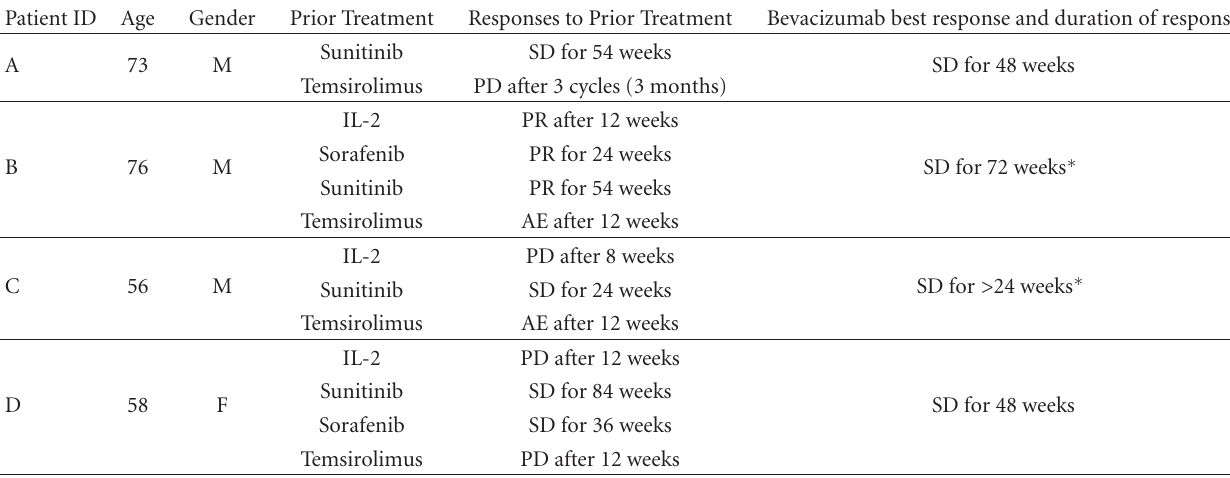
Table 1: Patient characteristics and responses to